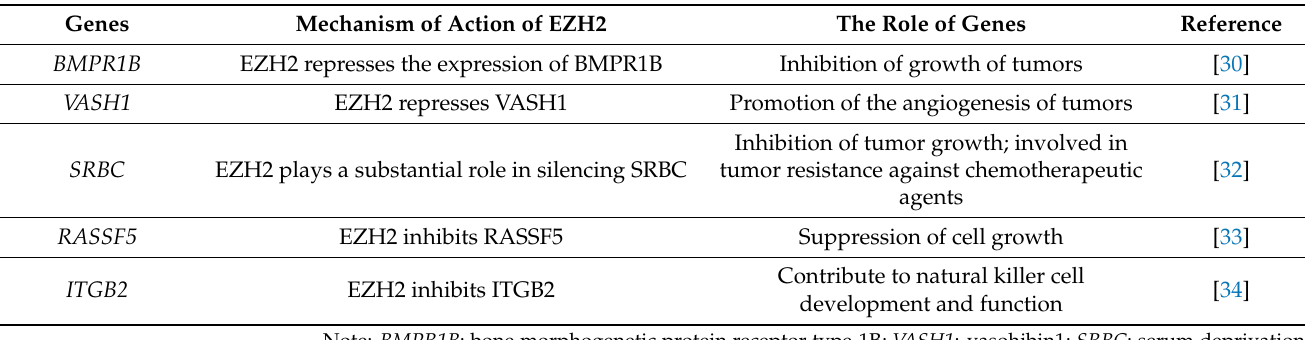
Table 2. The genes that are regulated by EZH2 through DNA methylation.